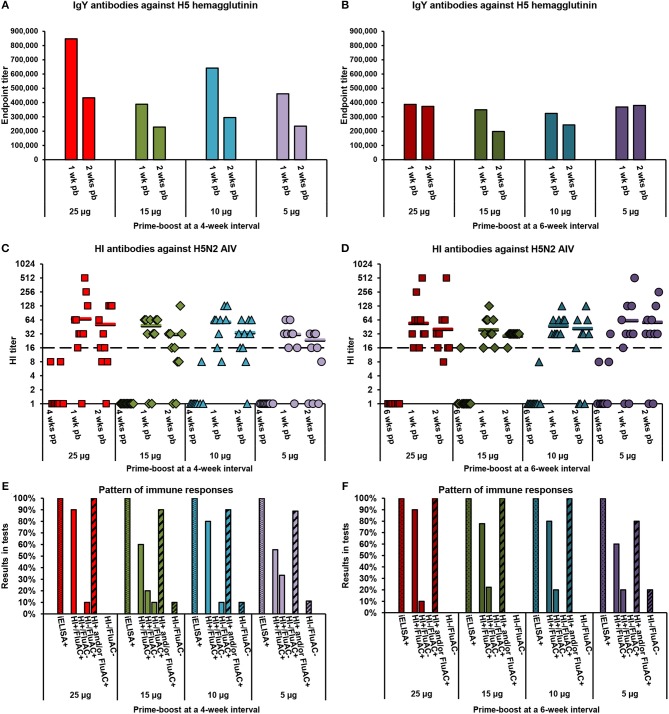
Serum antibody responses of layer chickens to vaccination with alum-adjuvanted rH5-E. coli. Eight groups of 3-week-old layer chickens (10 per group) in Exp 2 were vaccinated twice at 4-week (A,C,E) or 6-week (B,D,F) intervals with 25, 15, 10, or 5 μg of rH5-E. coli and aluminum hydroxide (alum) adjuvant. Sera collected post-prime (pp) and/or post-boost (pb) were analyzed for the presence of anti-H5 HA antibodies using the indirect and competitive ELISAs, H5 iELISA and FluAC H5, respectively, and a hemagglutination inhibition (HI) assay with H5N2 low-pathogenic (LP) AIV. Tests were performed and interpreted as described in the Materials and Methods section. (A,B) Endpoint titers of anti-H5 HA IgY antibodies in post-boost sera from chickens vaccinated at (A) 4-week and (B) 6-week intervals. Each bar represents the result for pooled sera collected from one group of chickens at the indicated time point. (C,D) Titers of HI antibodies against H5N2 LPAIV in post-prime and post-boost sera from chickens vaccinated at (C) 4-week and (D) 6-week intervals. Each symbol represents the result for one chicken at the specified time point. A value of 1.0 indicates that the HI antibody titer was below the detection limit (1:8). The horizontal lines are the geometric mean titers (GMT) of HI-positive sera (≥1:16), detected 1 or 2 weeks post-boost in particular groups of chickens. The dashed line indicates the cut-off value in the HI test (1:16). (E,F) Pattern of immune responses to the prime-boost vaccination at (E) 4-week and (F) 6-week intervals. Considering the results from all of the post-vaccination sera, chickens were classified as positive (+) or negative (−) in H5 iELISA (iELISA) or HI and FluAC H5 tests (HI/FluAC). Each bar represents a percentage of the specified category of chickens in each group.